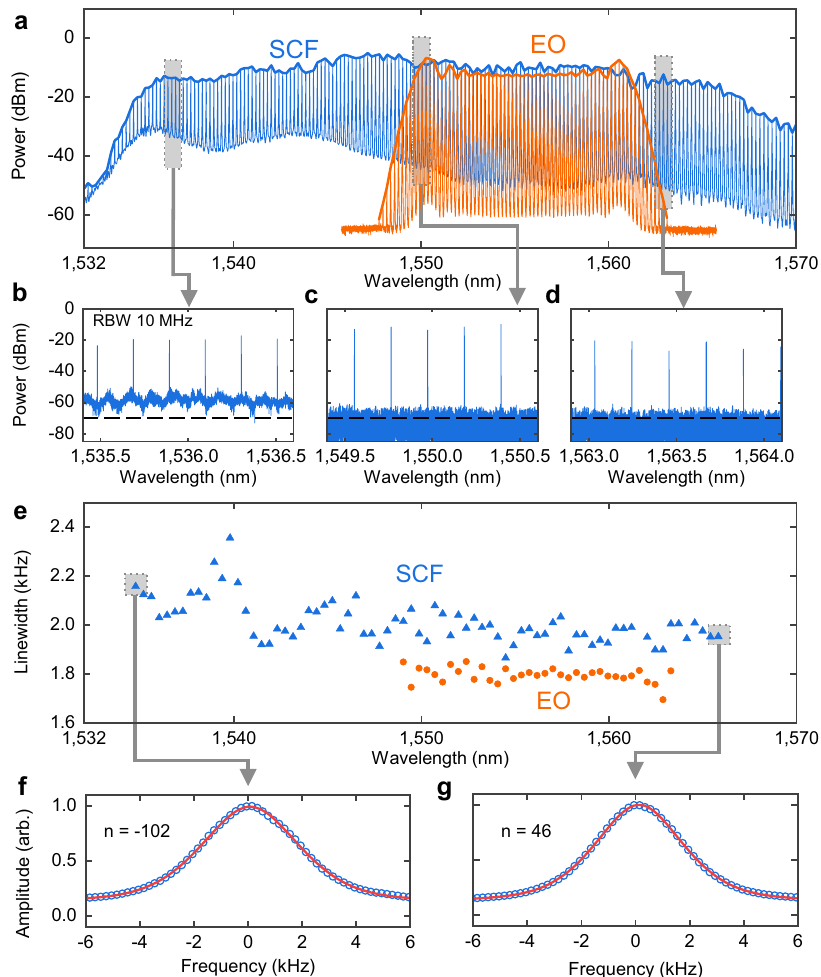
Fig. 3 C-band parametric frequency comb generation using SCF. a An electro-optic frequency comb with 26 GHz line spacing (orange) was temporally reshaped and launched into a 17 mm sample of SCF at an average power of 32 dBm. The optical spectrum of the broadened parametric comb (blue) was obtained at a resolution of 0.02 nm, achieving 143 tones across a 30.0 nm bandwidth. A 10 MHz resolution BOSA was used to obtain close-in traces at different points within the comb bandwidth ( b – d ). The dashed line shows the instrument noise fl oor. Results in ( c , d ) are both limited by the instrument noise fl oor. e The linewidth of the parametric comb was measured using the delayed self-heterodyne interferometer (DSHI) method with a 80 km delay line and pseudo-Voigt pro fi le fi tting. The pseudo-Voigt fi tting curves are shown for the two measured beat notes at the extremities of the SCF comb bandwidth ( f , g